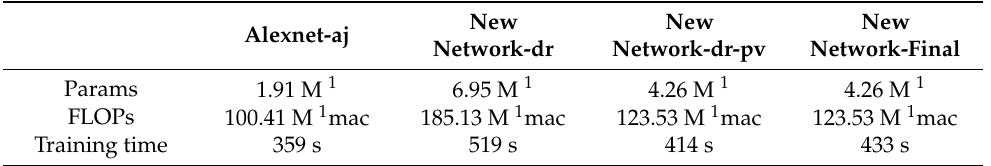
Table 6. Performance of the constructed models.